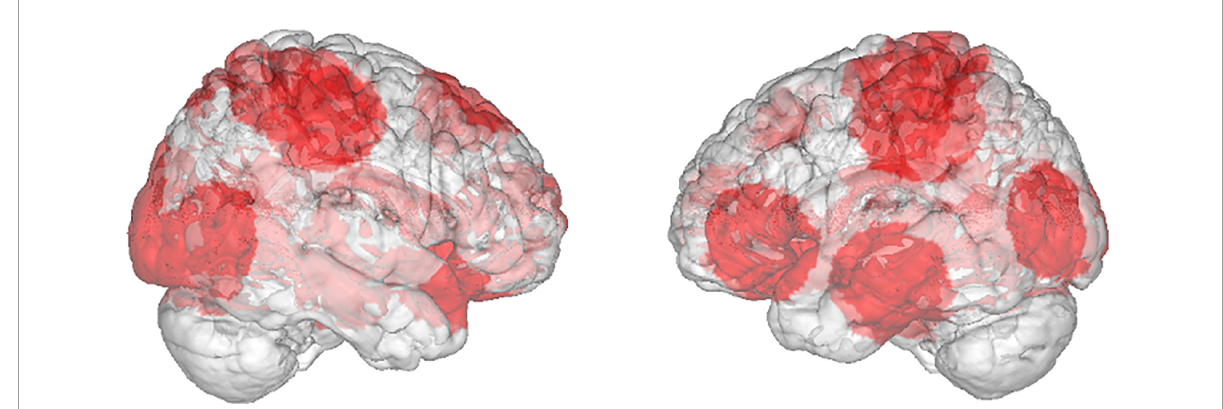
FIGURE4 Unthresholded ALE brain map resulted from food brand studies showing the diverse brain regions involved. It is overlaid on a glass brain for visualization. None of the clusters reached statistical